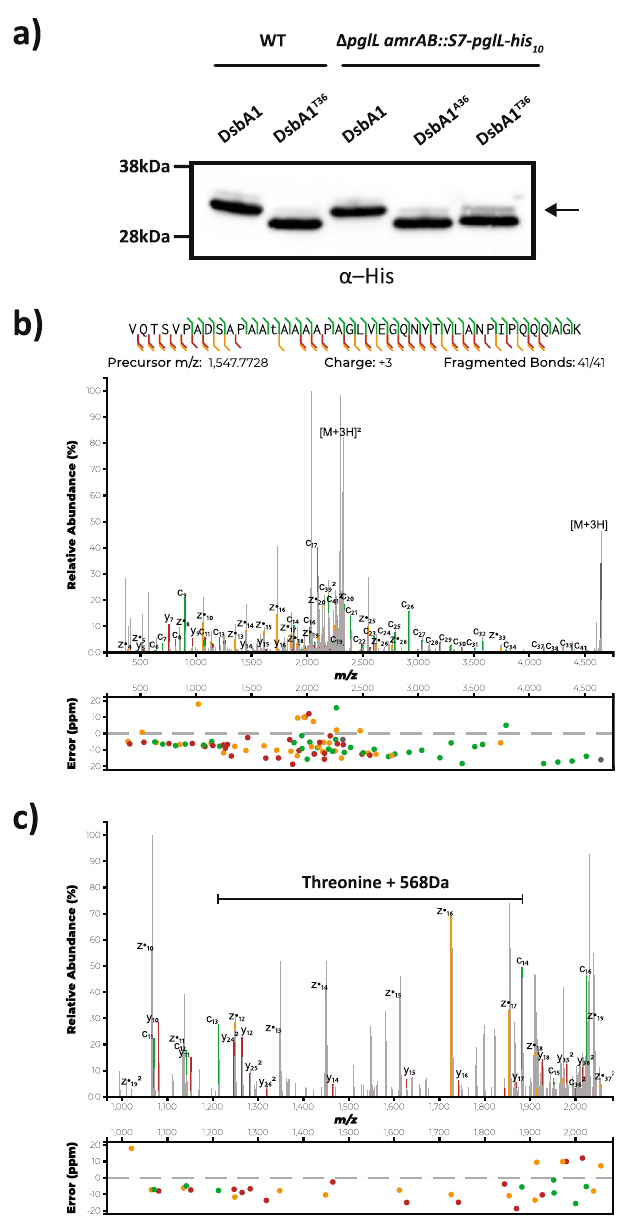
Fig. 3 Threonine residues undergo poor glycosylation in B. cenocepacia even with overexpression of pglL BC . a Western analysis of DsbA1 Nm -his 6 variants reveals a minor product, indicated with an arrow, is observed within DsbA1 Nm -his 6 T 36 when expressed within K56-2 Δ pglL amrAB::S7- pglL-his 10 . b , c Targeted MS analysis using EThcD fragmentation enabled the con fi rmation of glycosylation at residue T 36 within 23 VQTSVPADSAP AATAAAAPAGLVEGQNYTVLANPIPQQQAGK 64 . Glycosylation site within peptide denoted by glycoproteins across 294 publicly available B. cenocepacia